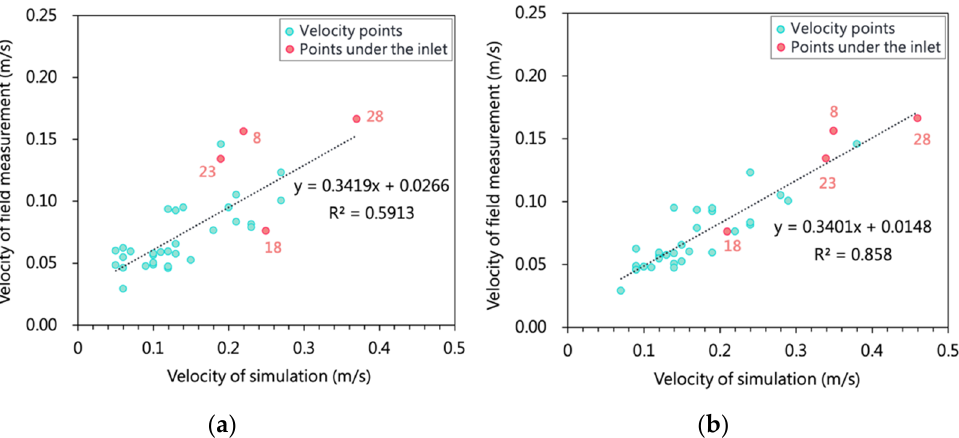
Figure 13. Simulation results of velocity in ( a ) simplified diffuser model and ( b ) detailed diffuser model.